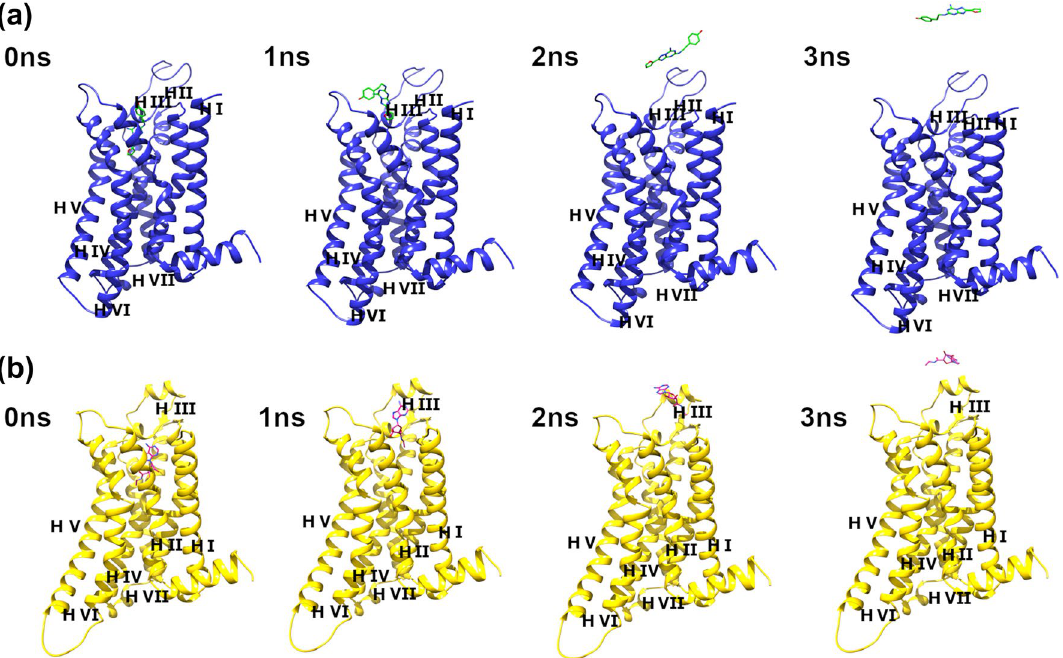
Figure 3. Snapshots at different time intervals from a representative SMD trajectory showing the unbinding of ligands with a pulling velocity of 0.0010 nm/ps. ( a ) Global view of the A2A AR (blue) in complex with the ligand ZMA241385 (green). ( b ) Global view of the A2A AR (yellow) in complex with ligand NECA (magenta). The receptor helix (H) numbers are indicated in roman